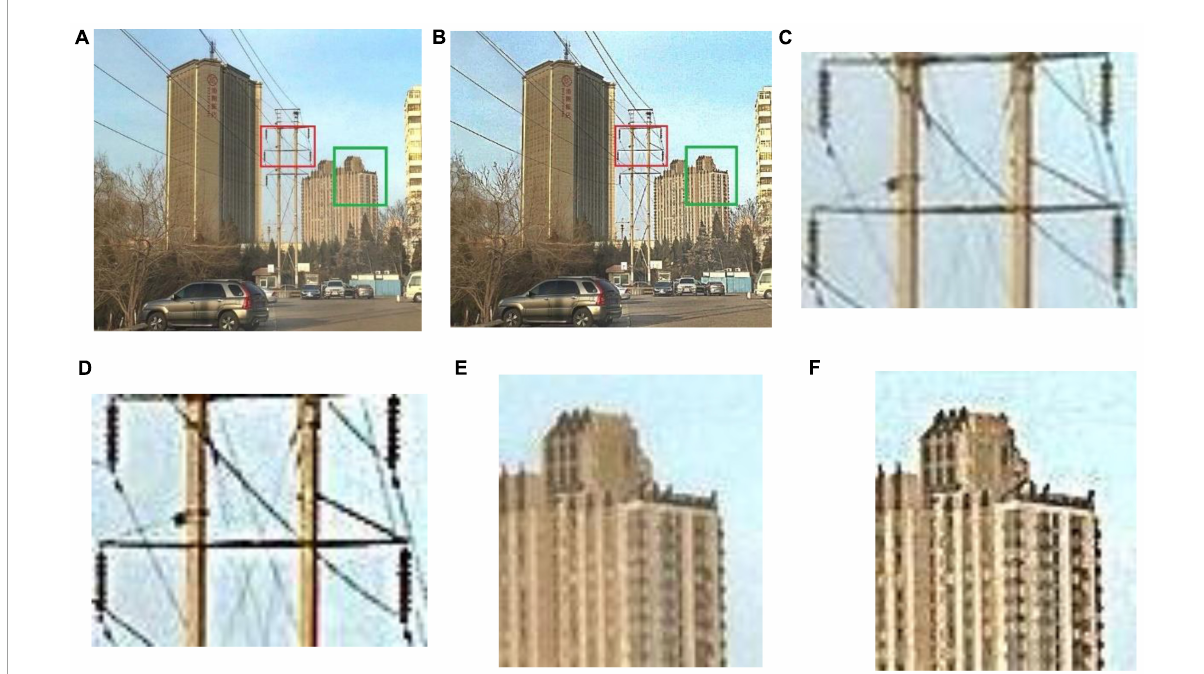
FIGURE7 Comparison of local details between the two methods. (A) Preliminary defogging result without sharpening; (B) Final defogging result after sharpening; (C) Local detail of intermediate defogging result (insulators); (D) Local detail of final defogging result (insulators); (E) Local detail of intermediate defogging result (buildings); (F) Local detail of final defogging result (buildings).